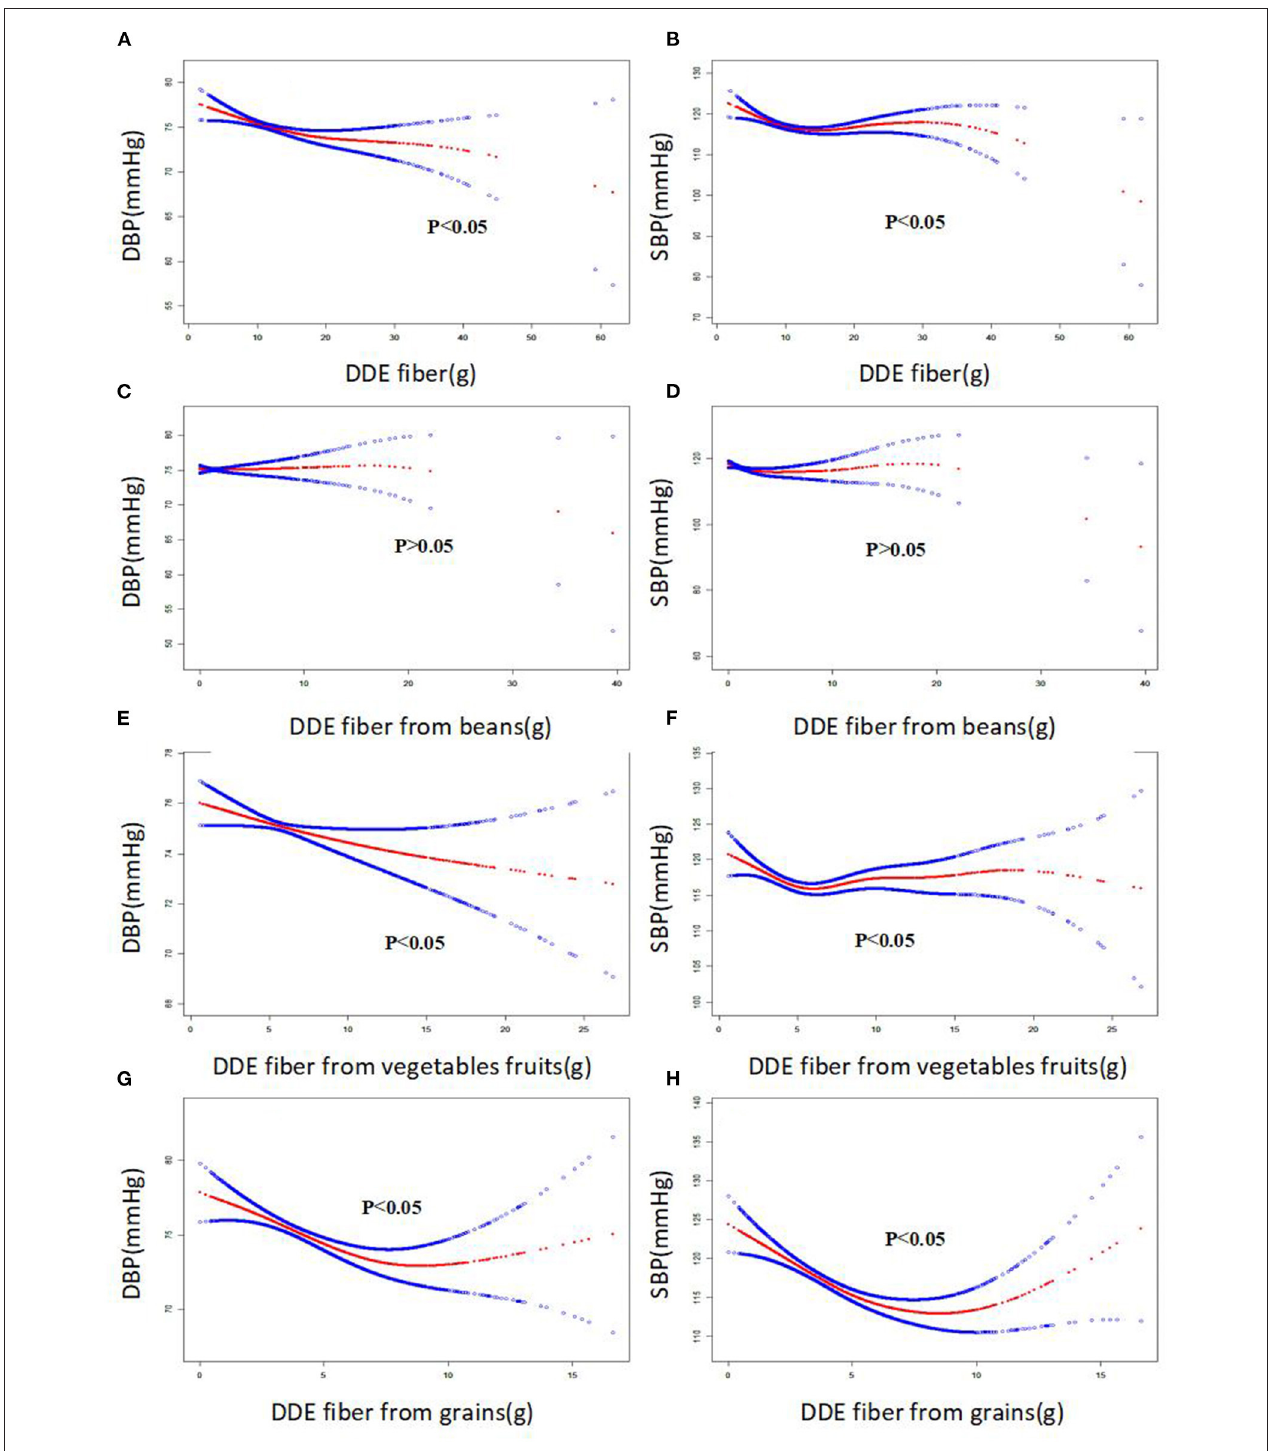
FIGURE 2 | The smooth curve of the associations between dietary fiber intake and systolic blood pressure and diastolic blood pressure (SBP and DBP, respectively).